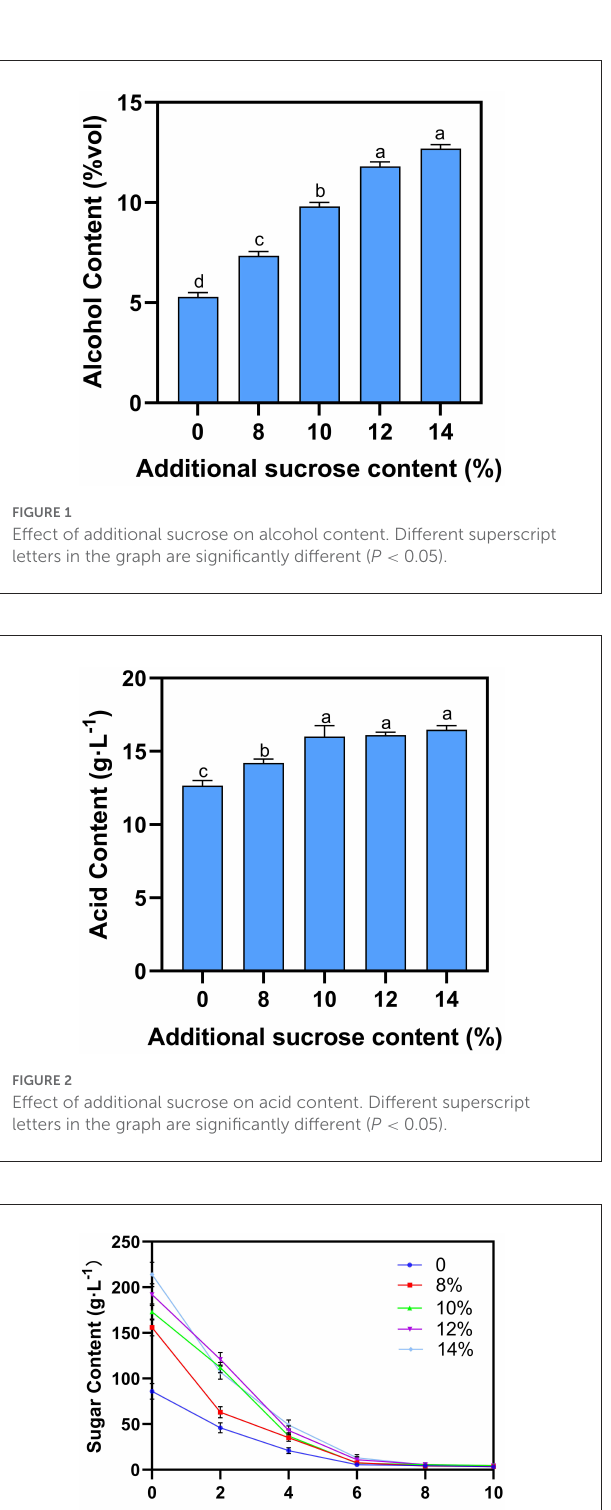
FIGURE5 Effect of additional sucrose on phenol content during main